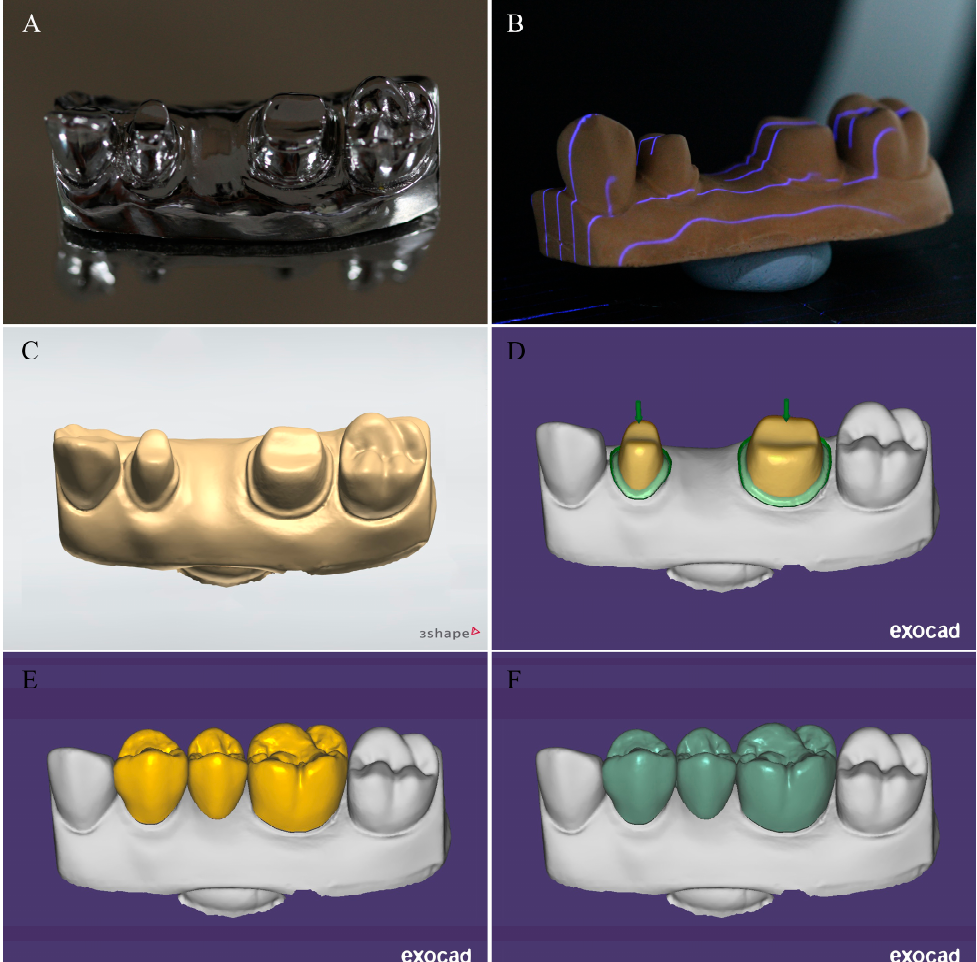
Figure 2. Scan process of model and design process of three-unit fixed dental prosthesis (3-unit FDP). ( A ) Metal model. ( B ) Scan process of model. ( C ) Virtual model. ( D ) Design process: Parameter setting of cement space. ( E ) Design process: Modification of prosthesis size and position. ( F ) Design process: Virtual 3-unit FDP.